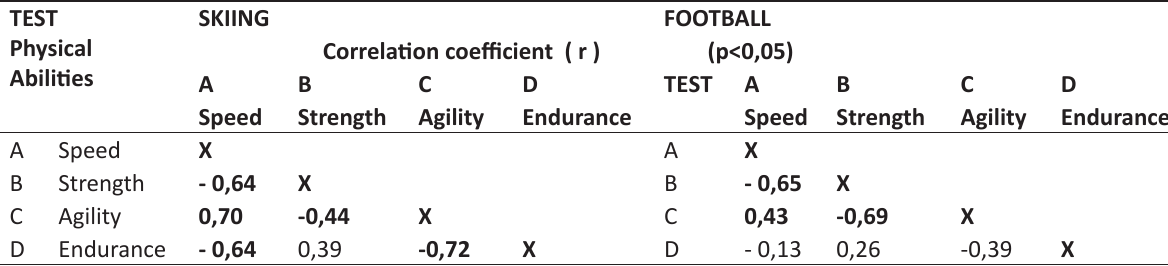
Table 3. Correlation coefficient between tests in ski and football specialization